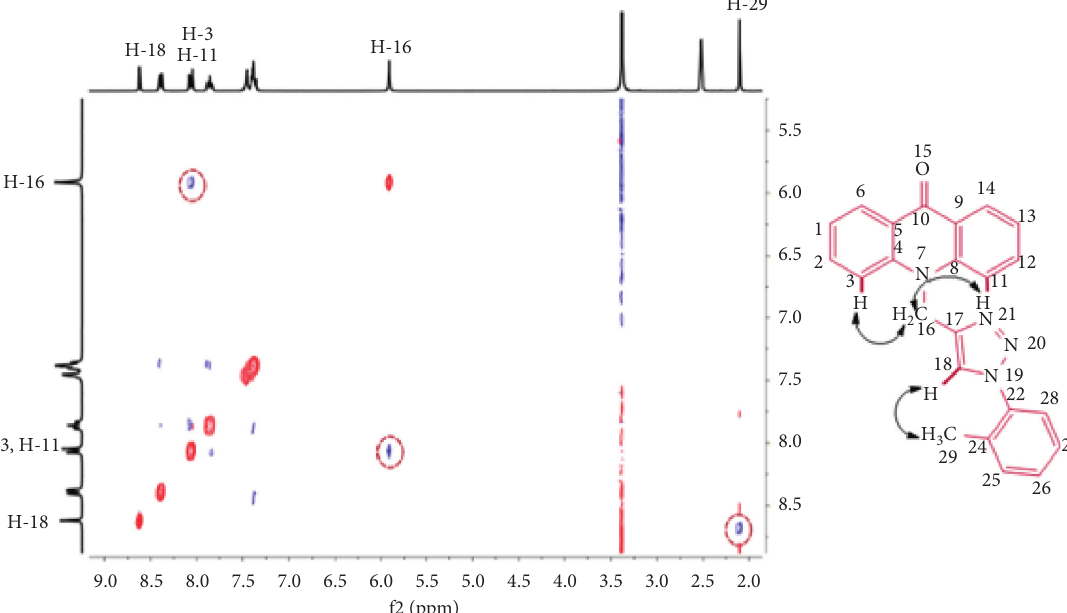
Figure 5: The 1 H- 1 H NOESY spectrum of compound 2a.